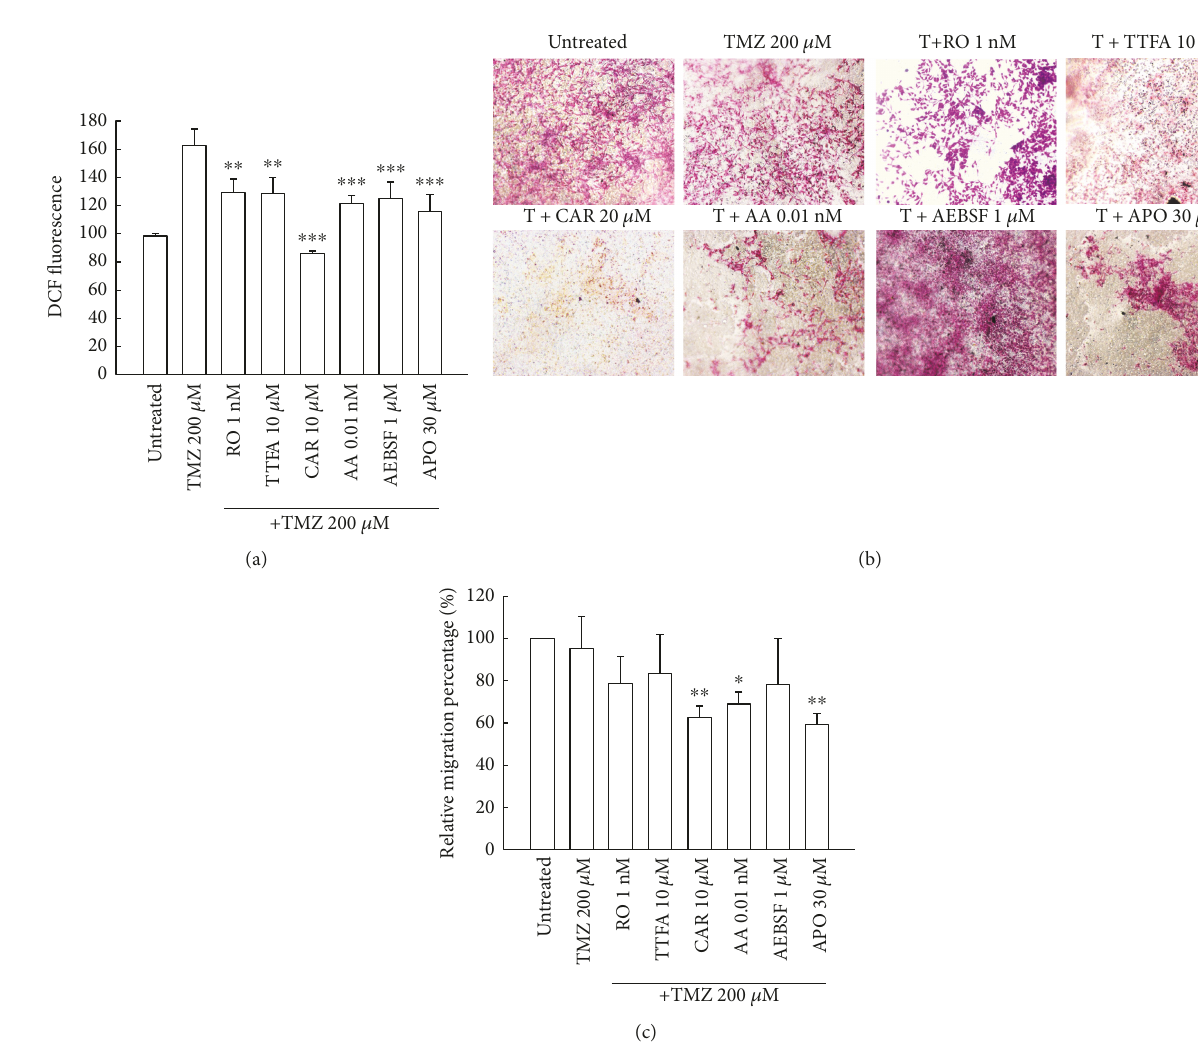
Figure 6: Inhibition of critical ROS events enhances antimigration with TMZ treatment. U-87 MG cells (1 × 10 6 ) were plated in 60mm cultured dishes for 24 h and then treated with TMZ (200 μ M) alone for 48 h or pretreated with 1nM rotenone (RO, a complex I inhibitor), 10 μ M 2-thenoyltri fl uoroacetone (TTFA, a complex II inhibitor), 10 μ M carboxin (CAR, a complex II inhibitor), 0.01 nM antimycin